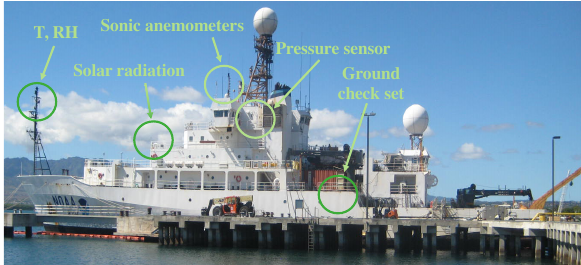
Figure 5. The location of key surface meteorological instruments on NOAA Ship Ronald H. Brown